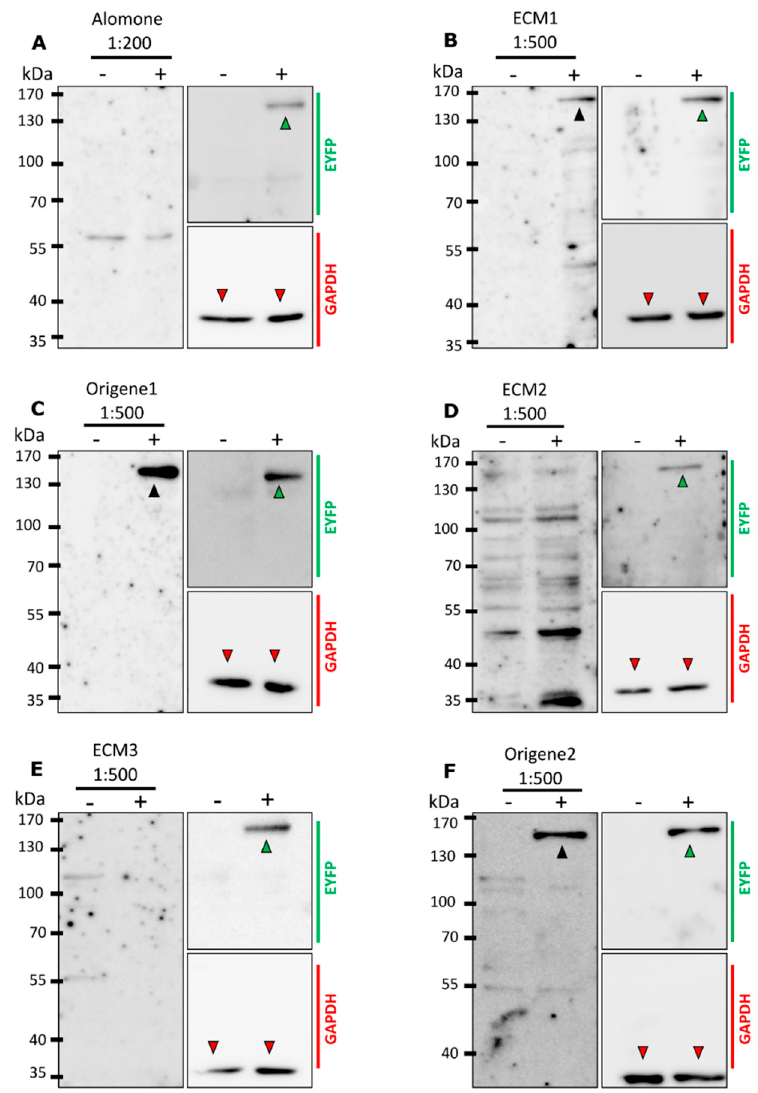
Figure 3. Western blot analysis for TRPM8 antibodies specificity. ( A – F ) TRPM8 immunoblots using ( A ) Alomone ( B ) ECM1, ( C ) Origene1, ( D ) ECM2, ( E ) ECM3 or ( F ) Origene2 antibodies. ( − ) lanes: untransfected HEK-293 cells, (+) lanes: HEK-293 cells transfected with mTRPM8-EYFP. Left: Immunoblot with each TRPM8 antibody. Right-top: EYFP immunoblotting on the same membrane. Right-bottom: GAPDH loading control. Black arrowheads indicate mTRPM8-EYFP bands revealed with antiTRPM8 antibody. Green arrowheads indicate mTRPM8-EYFP bands revealed with anti-GFP antibody. Red arrowheads indicate GAPDH bands. All blots were repeated at least 3 times to exclude a technical artefact when no anti-TRPM8 signal was observed. For each replicate, the same lysate was used for all antibodies.